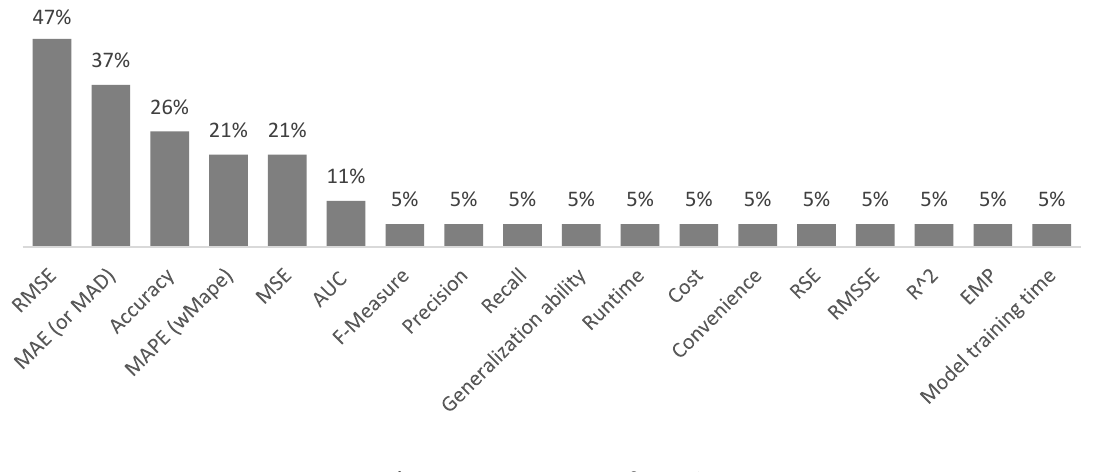
Figure 4. Frequency of